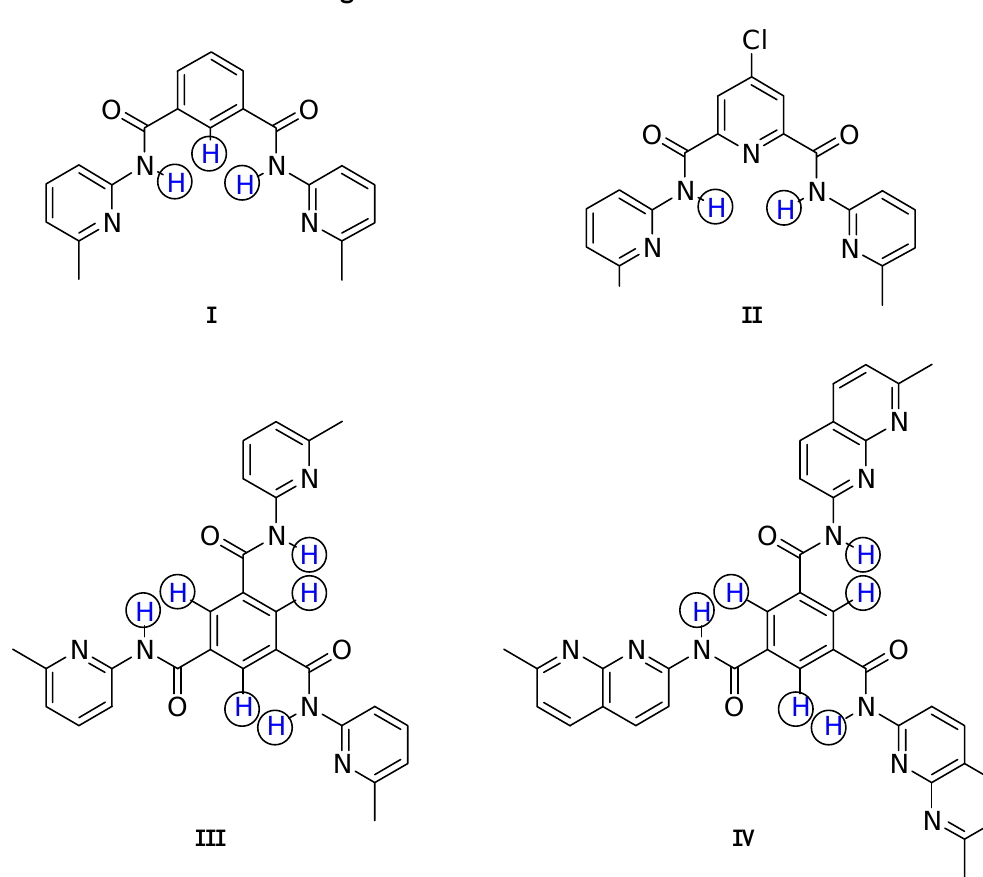
Figure 2. Structures of hosts I - IV